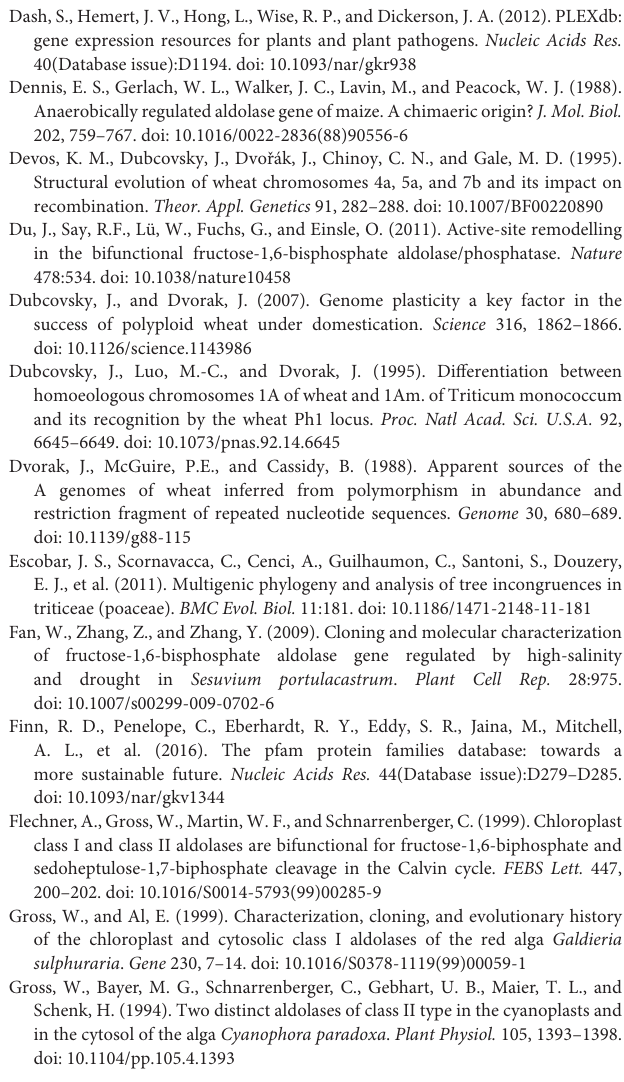
Figure S4 | The alignment of FBA protein sequences among wheat and other species. (A) The activity sites among the TaFBA1 ∼ 18 corresponded to those sites among FBA isozymes of rabbit and human. The activity sites are indicated in black frames. (B) The activity sites among TaFBA19 ∼ 21 corresponded to those sites among FBA isozymes of Thermus aquaticus . The activity sites are indicated in black frames. The red stars represent substitution mutations and deletion sites. Table S1 | Pairwise alignments of TaFBA genes. The number above the dash line are the identity between cDNA sequences, and the number below the dash line represent the identity between amino acid sequences. Table S2 | Gene-specific primers for mapping and cloning. Table S3 | FBA genes of wheat and wheat relatives. Table S4 | Annotation of transposable elements on TaFBA genes. Table S5 | HMM search hits of FBA proteins.